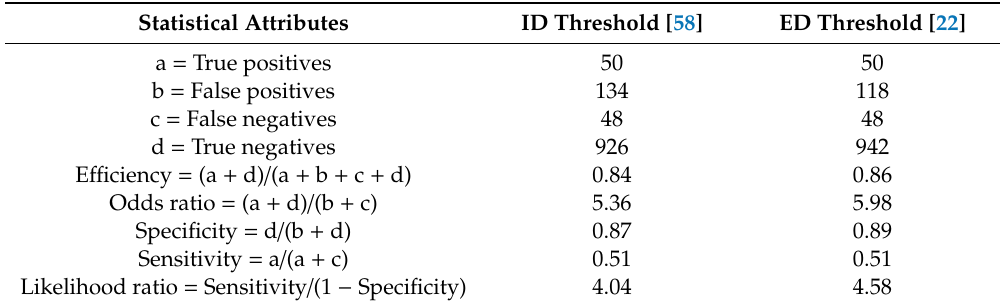
Table 2. Prediction performance of empirical